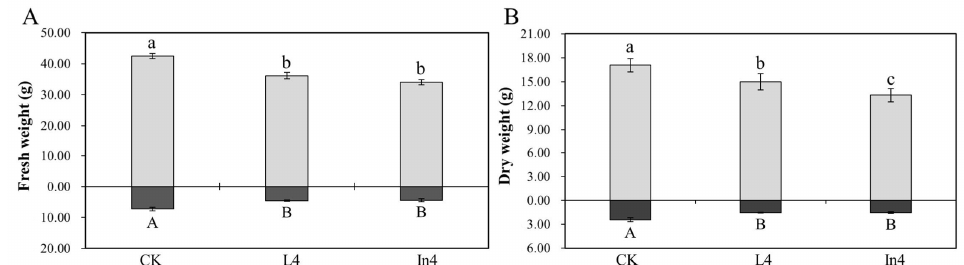
Figure 1. Changes in shoot and root biomass in P. koraiensis under different supplementary lights. ( A ) Fresh weight. ( B ) Dry weight. CK: Control. L4: Supplementary LED for 4 h. In4: Supplementary incandescent lamp for 4 h. Letters of a, b, and c are labels for the shoots, and A and B are labels for the roots.